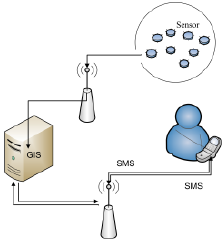
Figure. 3 Exchanging data between sensor and mobile